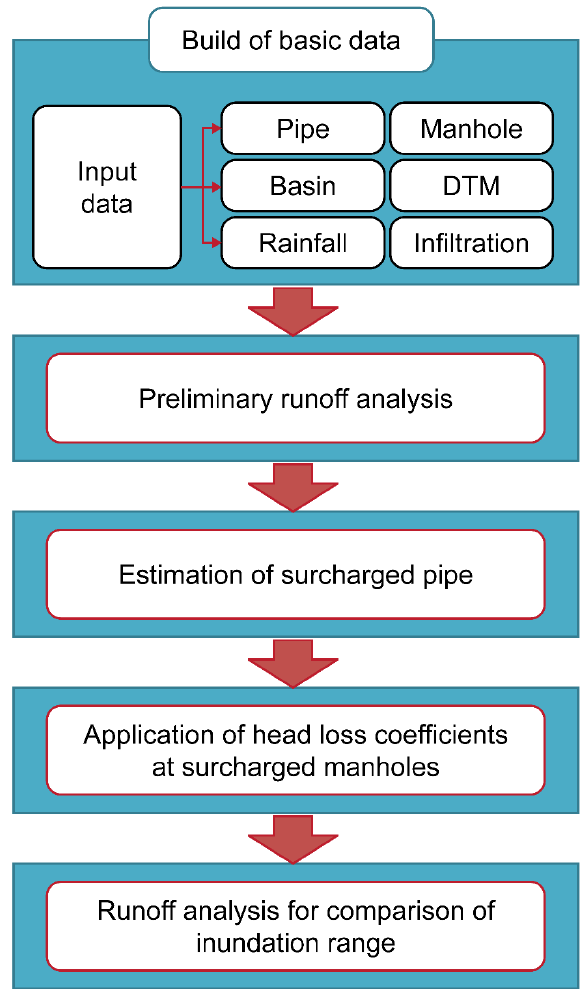
Figure 6. Flow analysis process in inundation area.